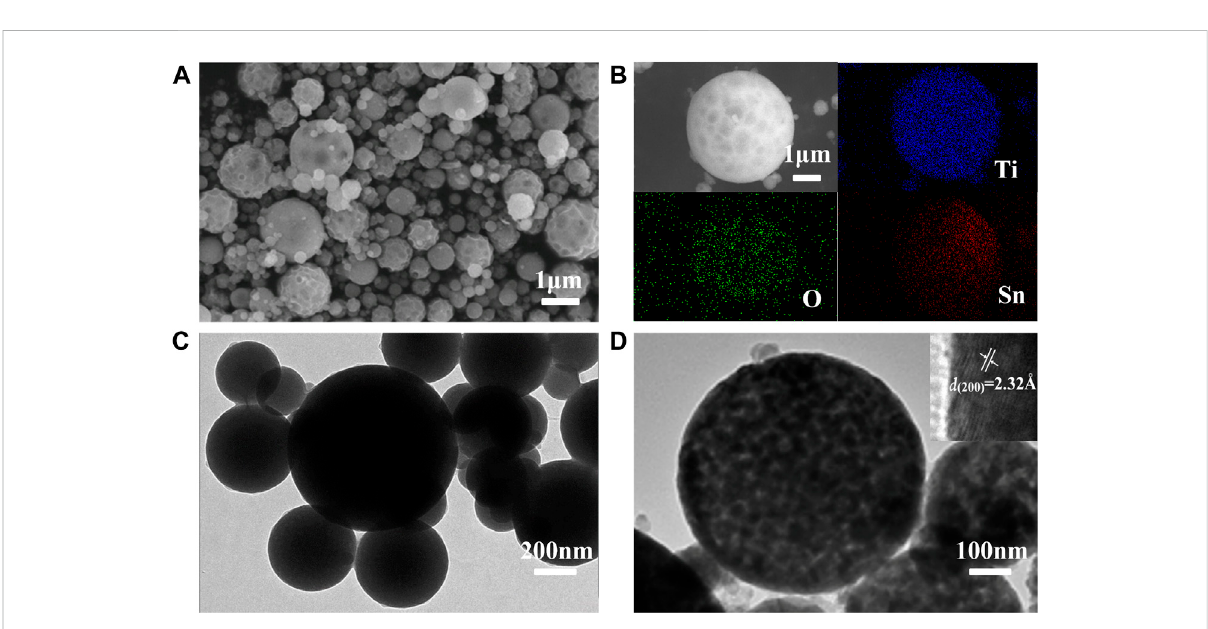
FIGURE 4 (A,B) SEM and elemental mapping images and (C,D) TEM images of the Ti